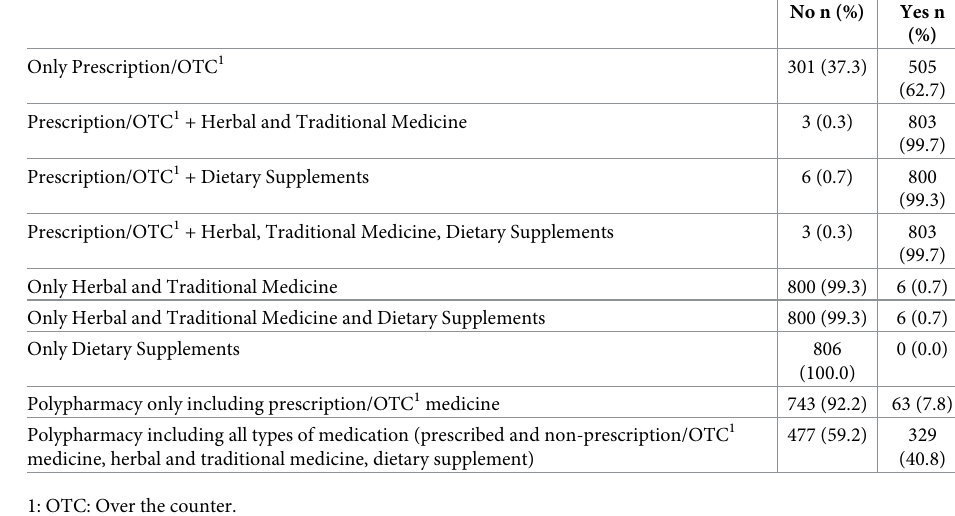
Table 1. Medicine use among patients with Type 2 diabetes in Thai Binh,